Question: In one sentence, what is this figure communicating?
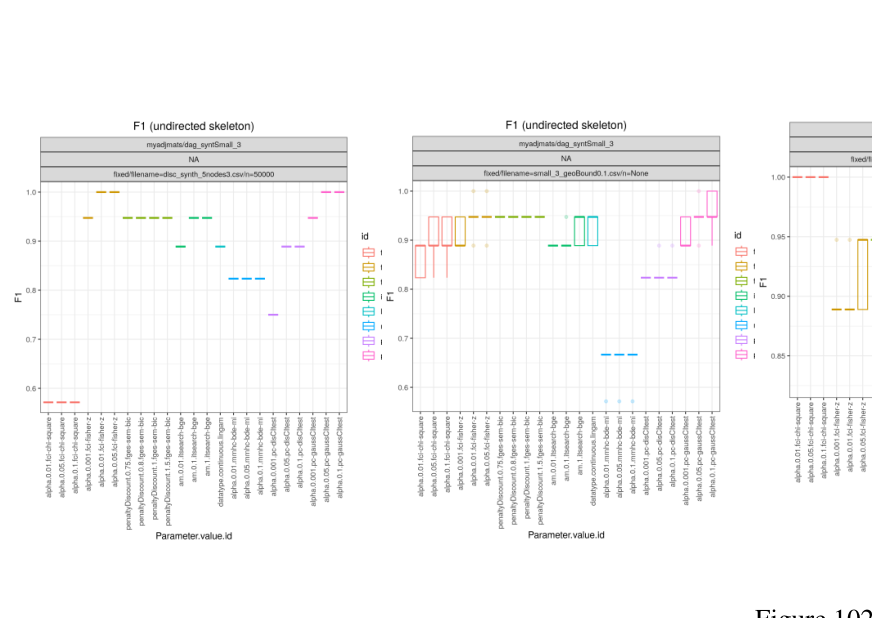
Answer: F1 Scores on the Synthetic 5 nodes data set. Dis- cretized, no noise.